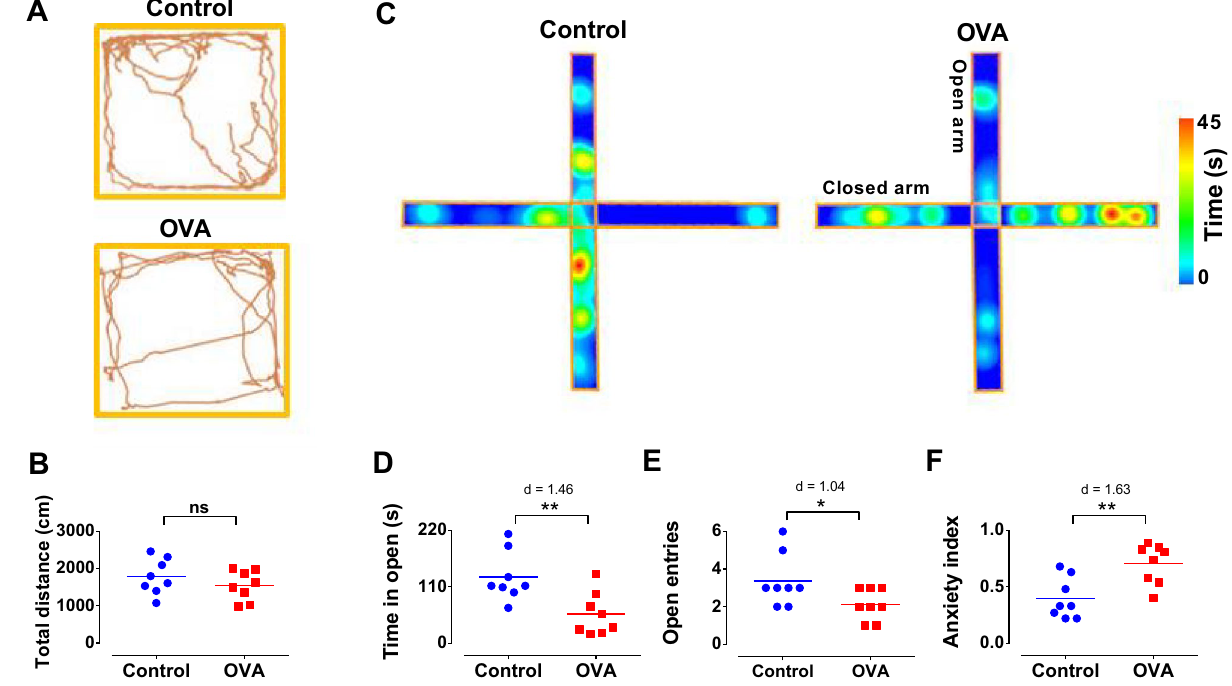
Figure 3. Locomotor activity and anxiety-like behavior. ( A ) Representative traces of total distance traveled for control and OVA rats in the open field test. ( B ) Quantification of total distance traveled for in the open field test. ( C ) Sample heat map of elevated plus-maze exploration for the control and OVA groups. Warmer colors illustrate increased time spent on the segment. ( D-F ) Quantification of the time spent on open arms ( D ), the number of open entries ( E ), and anxiety index ( F ). The horizontal bars represent mean values. Data were analyzed by t-test, n = 8 per group. *p < 0.05, **p < 0.01 compared to control. OVA,